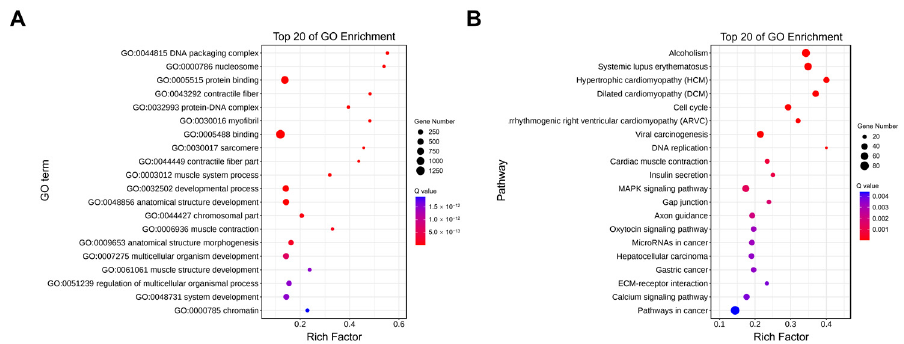
Figure 5. Enrichment analysis of trans-target genes of DE lncRNAs. ( A ) The top 20 significant GO terms. ( B ) The top 20 significant KEGG pathways. The color of the circle represents the Q value. The size of the circle indicates the number of target genes.